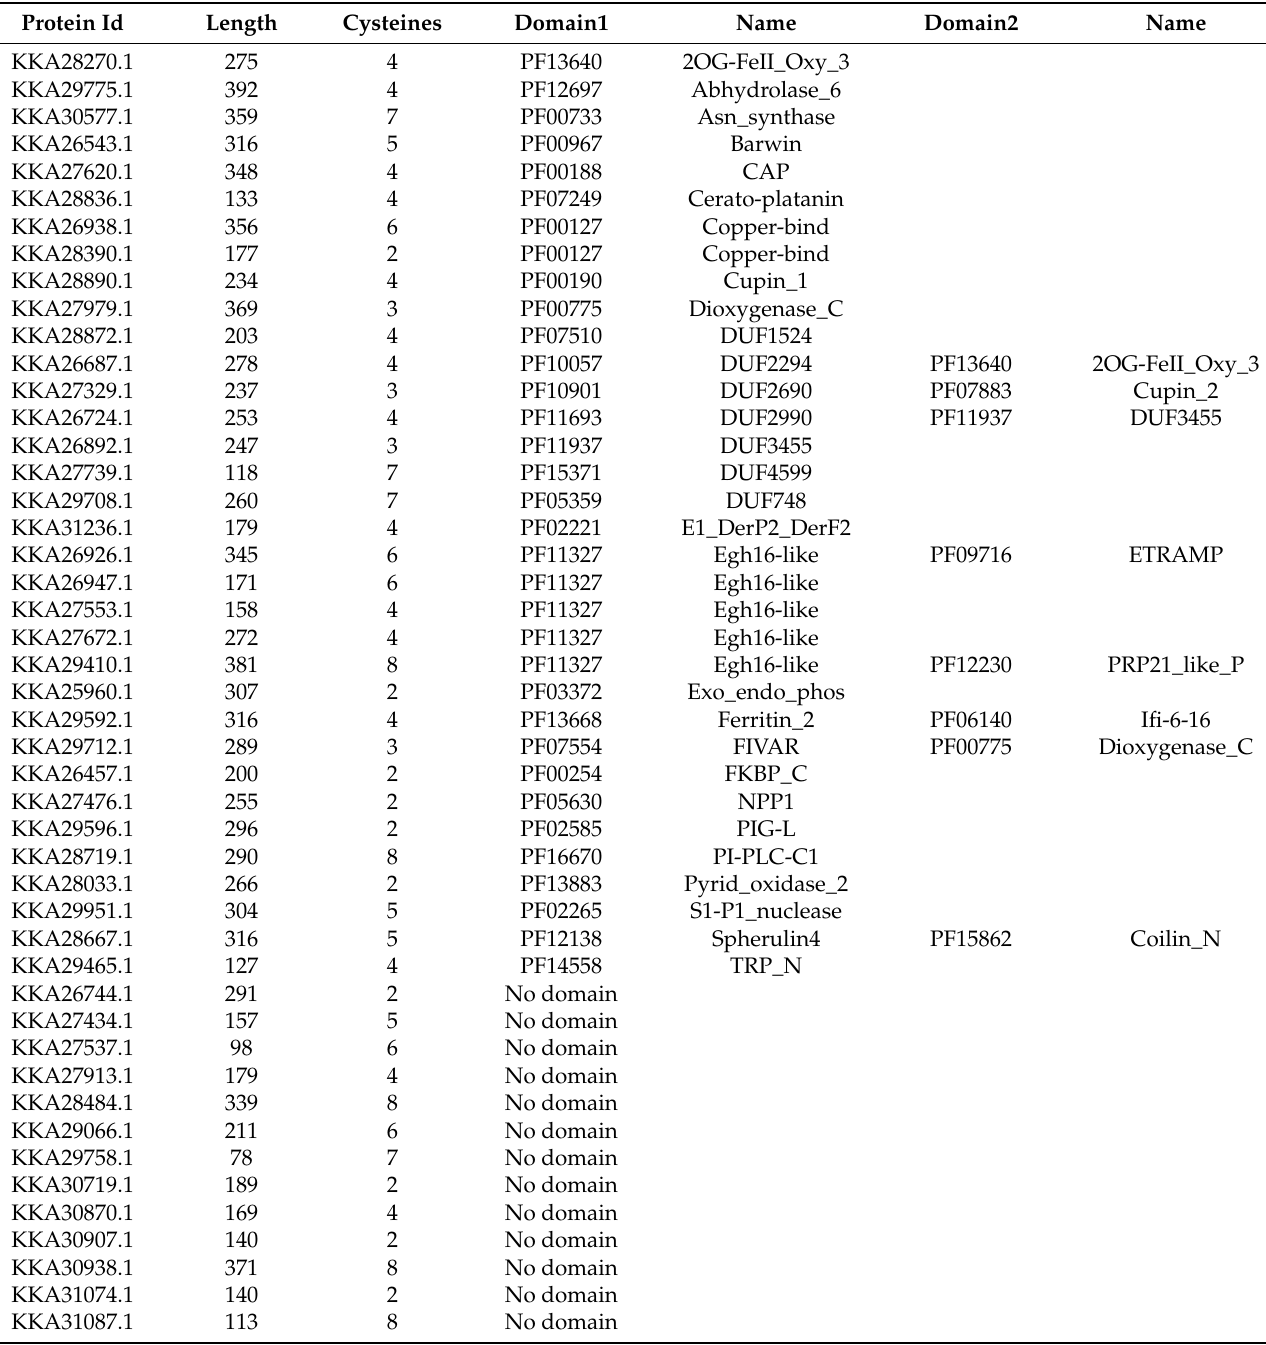
Table 4. Putative effectors in the secretome of T. punctulata